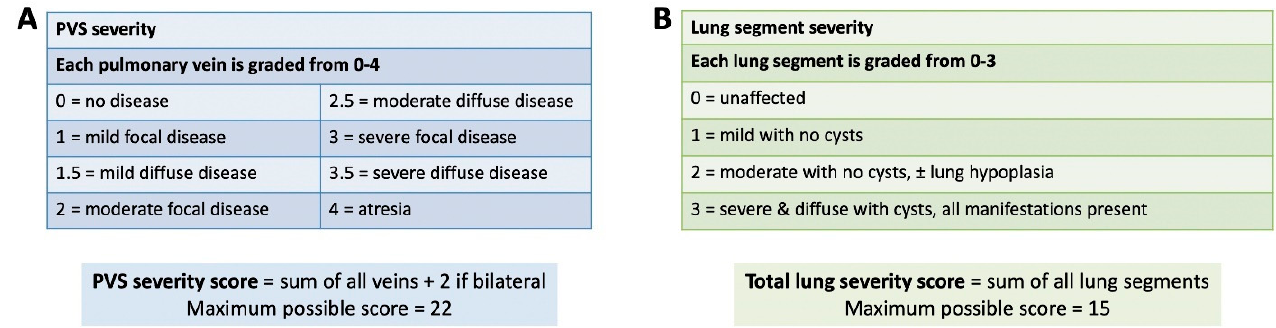
Figure 1. Calculations for pulmonary vein stenosis (PVS) severity score and total lung severity score. PVS severity score was the sum of individual PVS severity scores +2 if bilateral disease was present ( A ), and total lung severity score was the sum of lung segment severity scores ( B